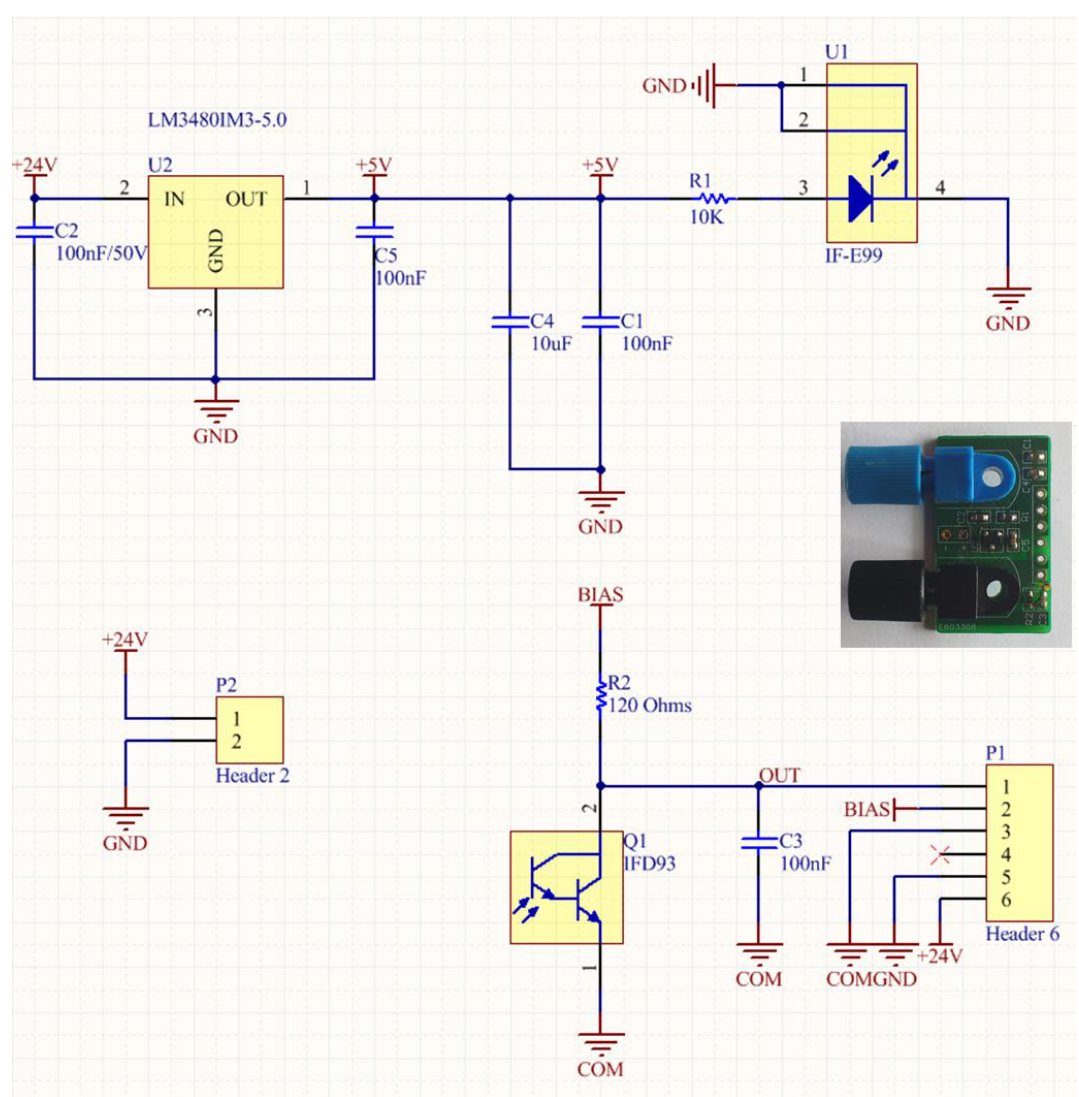
Figure 13. Schematic of the compact optical interface for the integration of the optical transceiver module in the wireless ZigBee unit. Inset: Photograph of the developed PCB with the attached